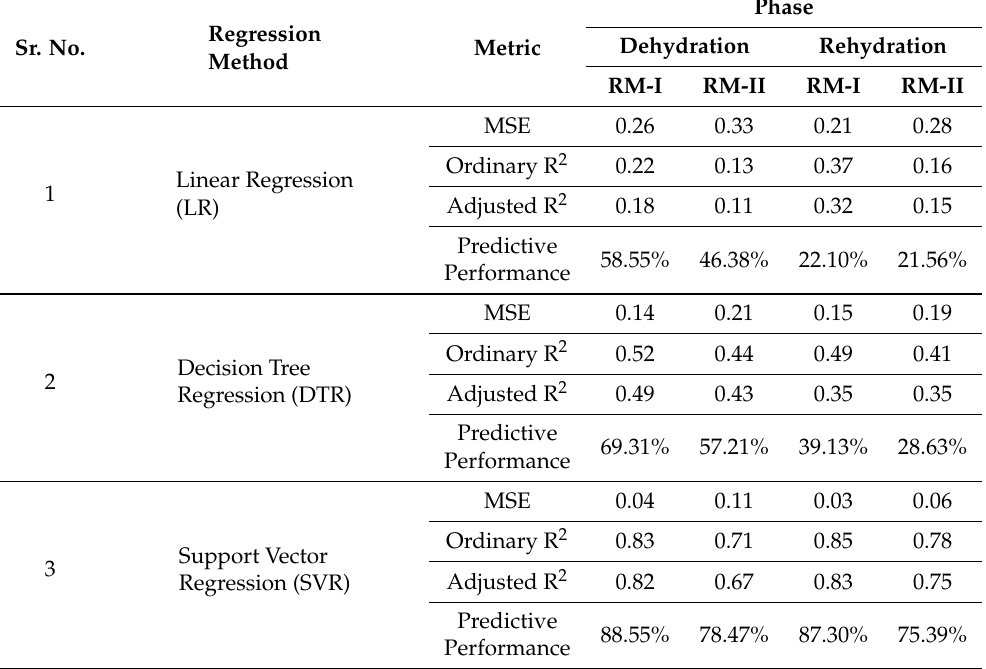
Table 6. Results for general analysis—Case 1: building separate regression models for dehydration and rehydration phases (RM-I: regression models built using ∆ F 1 t , ∆ F 2 t , ∆ F 3 t , and ∆ F 4 t as predictors; RM-II: regression models built using ∆ PV t and ∆ USG t as predictors).